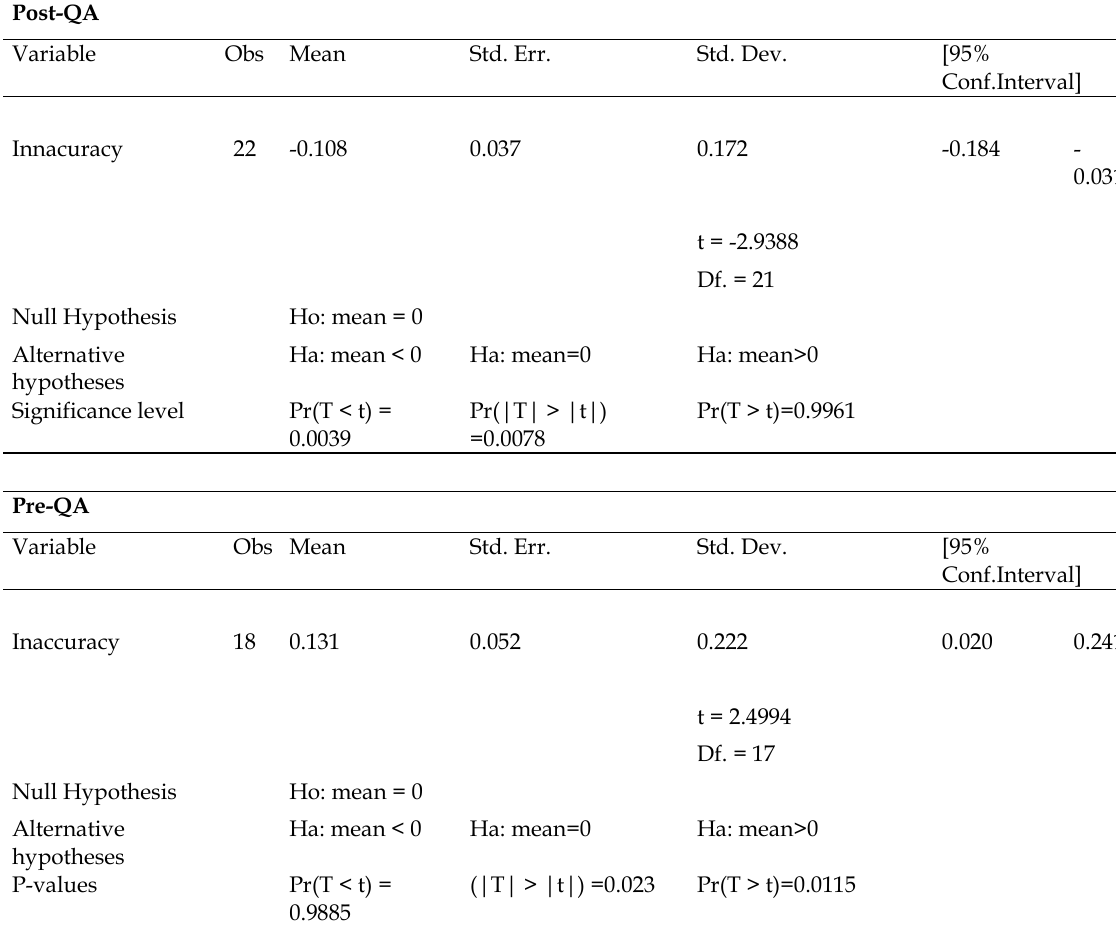
Table 2. Single sample t-test for mean different from